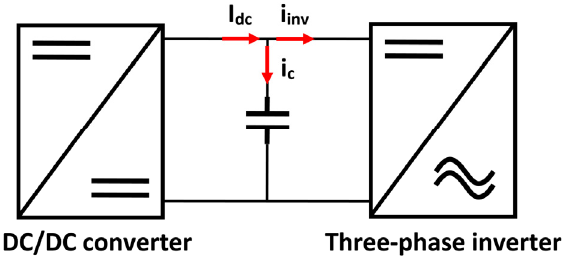
Figure 10. Identi fi cation of study currents.